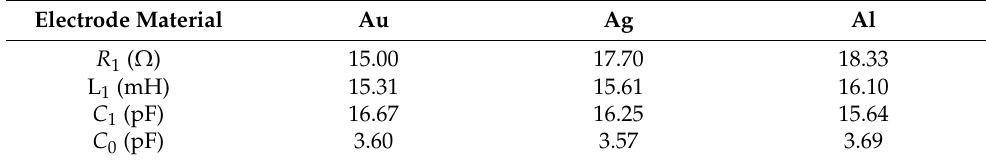
Table 3. Equivalent parameters of QCM resonator devices with different electrode materials. Electrode